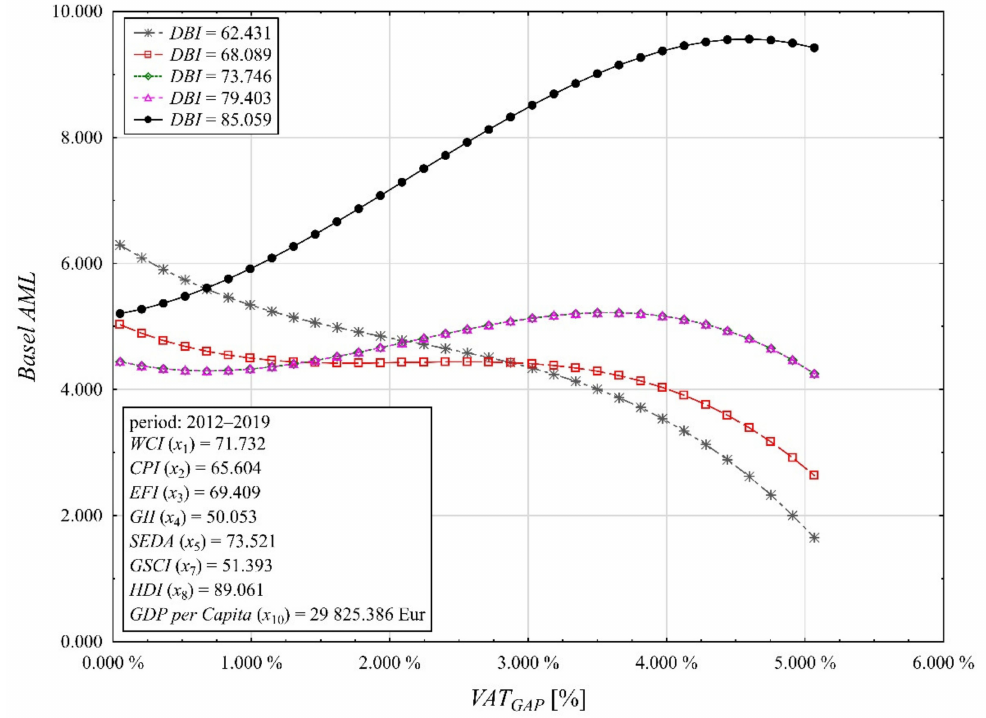
Figure 3. Dependence of the change in the value of the Basel AML index on the change in the value of VAT GAP and the DBI index based on model (21). Source: Compiled and calculated by the authors using Statistica 13.5, Matlab2019b and JPM 11.4.2. Comparison of Developed Models (linear and